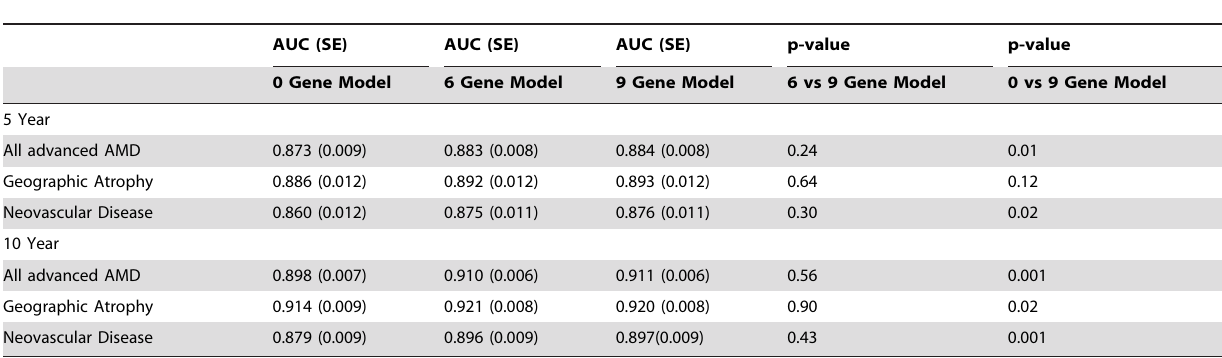
Table 6. Area Under the Curve Statistics for Progression to Advanced Age-Related Macular Degeneration, Geographic Atrophy and Neovascular Disease at 5 and 10 Years After